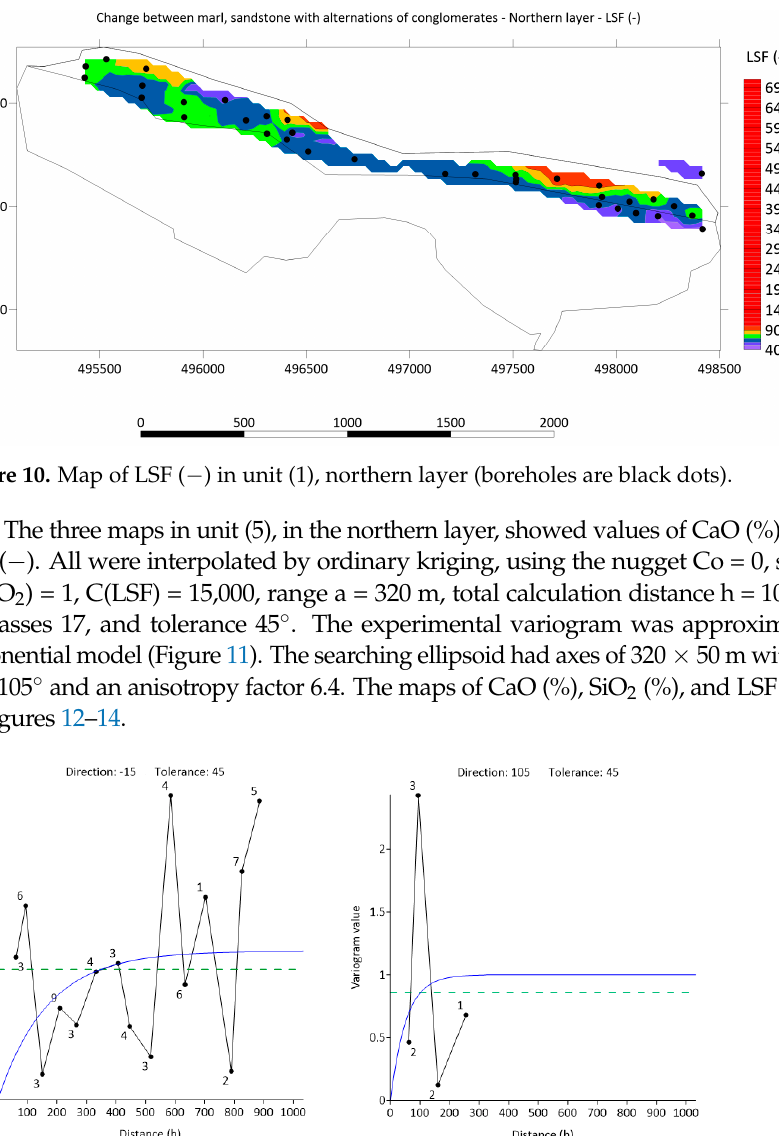
Commented [M2]: Please change commas to periods to indi- cate decimals. E.g., change 5,5 into 5.5 Commented [NB3R2]: Done.